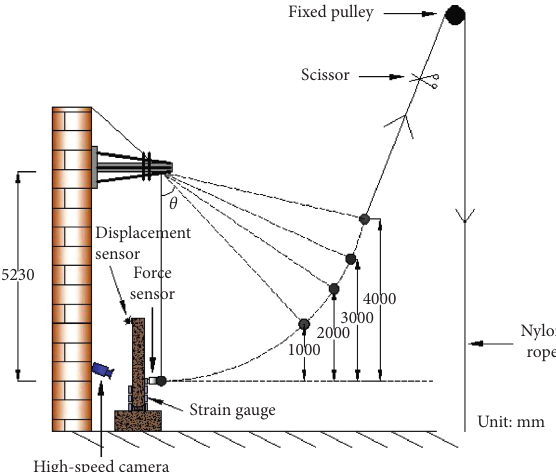
Figure 3: Experimental schematic diagram.